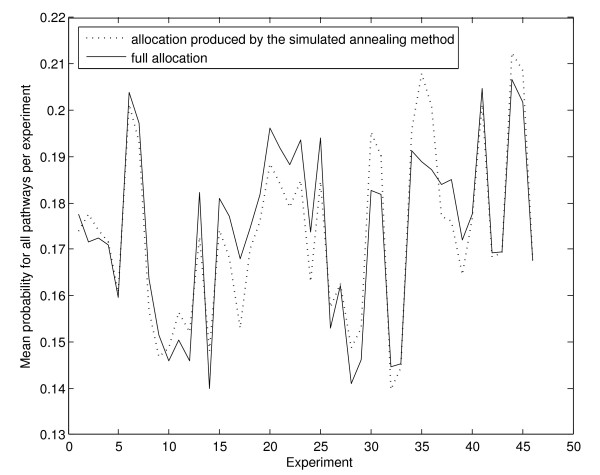
Mean probability of observing the gene expression in hand, per pathway and experiment by chance. The mean values per experiment are estimated upon full allocation of multi-membership genes to pathways (sold line) and processing of the dataset with our method (dotted line).